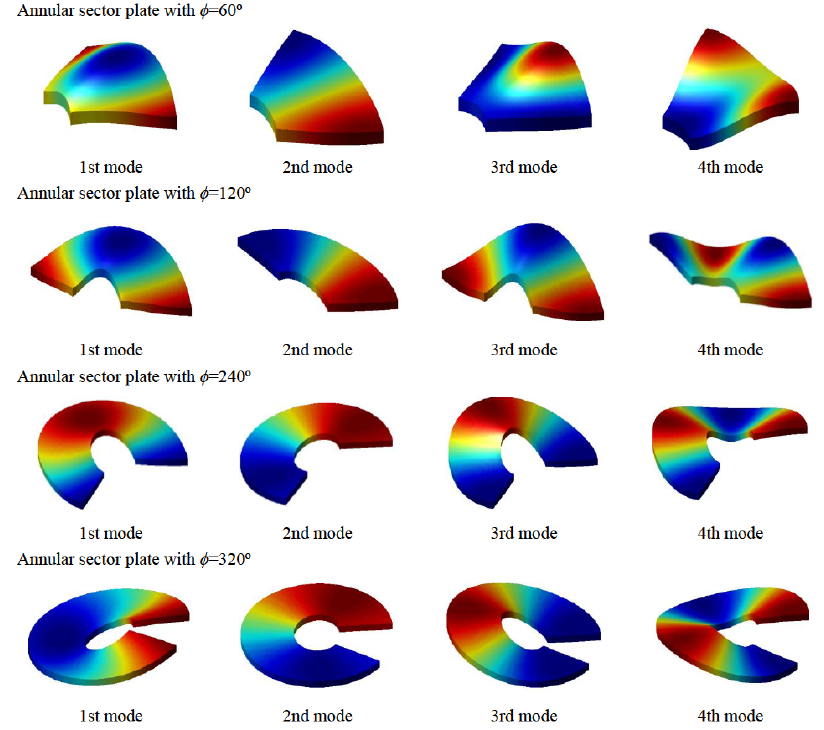
Figure 6: Mode shapes of FGX-CNT reinforced composite annular sector plates with E 2 E 2 E 2 E 2 boundary